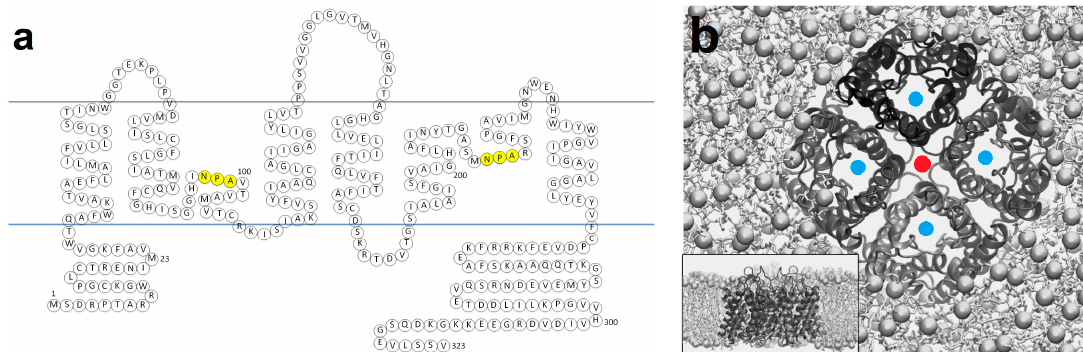
Figure 1. Aquaporin structure: ( a ) primary sequence of Aquaporin 4 (AQP4), the water channel with the highest recorded water permeability (see Table 1), highlighting the NPA (Asn-Pro-Ala) residues in yellow; ( b ) tertiary structure of the AQP4 homotetramer showing four water pores (marked with a blue dot) and the ‘fifth pore’ produced by formation of the tetramer (marked with a red dot). Adapted from an image originally published in [33] .